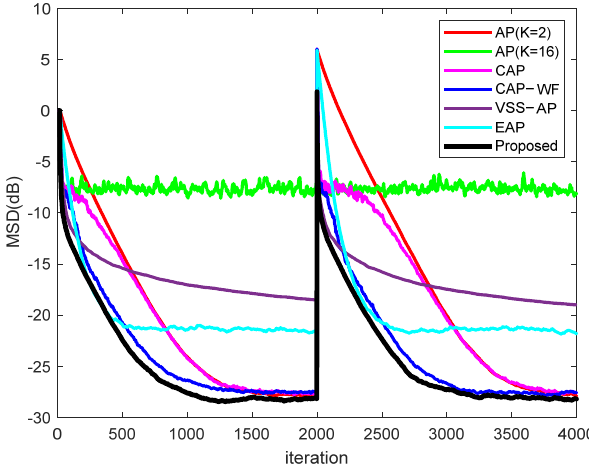
Figure 7. Convergence curves of the proposed algorithm and the conventional AP, CAP, CAP − WF, VSS − AP, and EAP algorithms in a non-stationary environment with SNR = 20 dB.